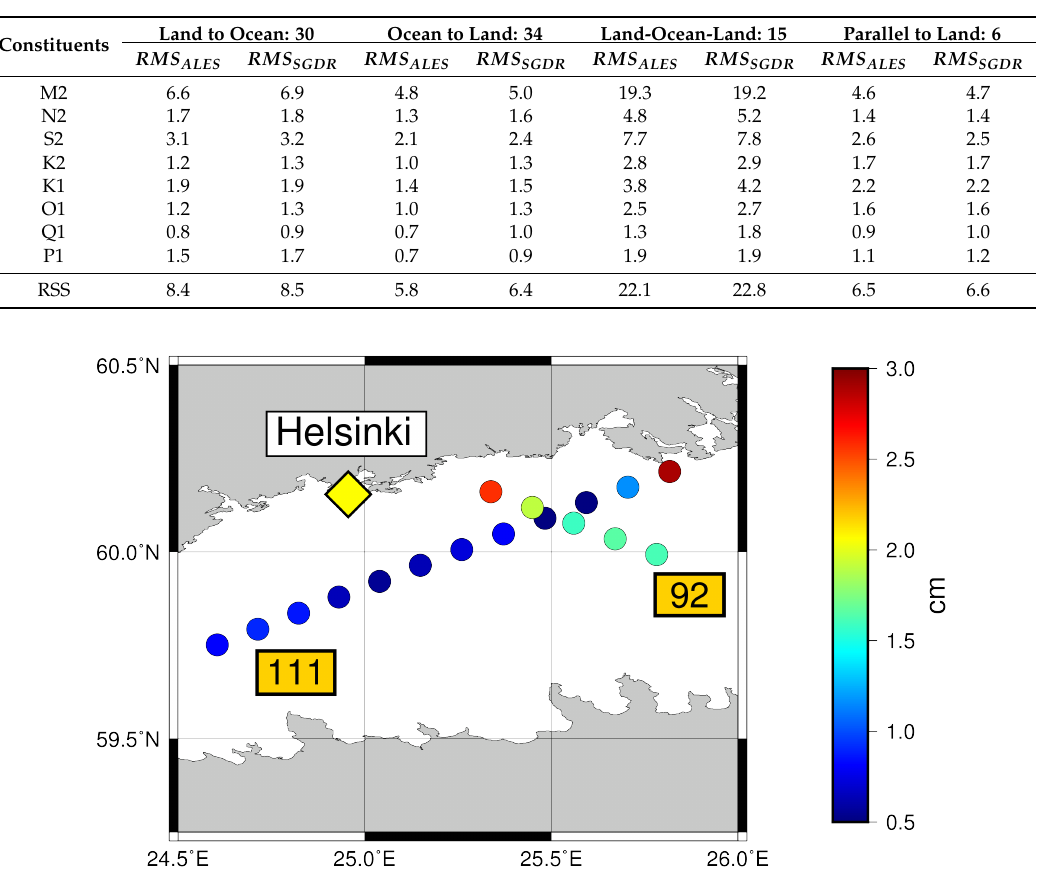
Figure 9. RMS values for M 2 constituent computed with ALES solutions for tracks 111 ( ascending ) and 92 ( descending ). The tracks face the tide gauge station of Helsinki ( diamond-shape marker ). The nodes of each track are represented by the round markers and the color shows the value of the RMS with respect to the tide gauge, in